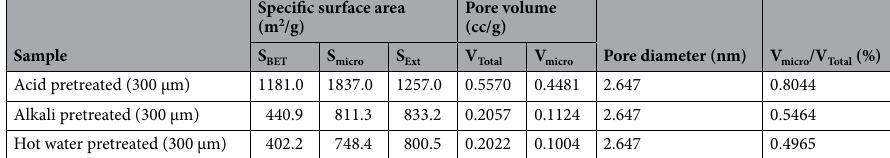
Table 12. Pore characteristics of corn cobs plus rice husks biomass.